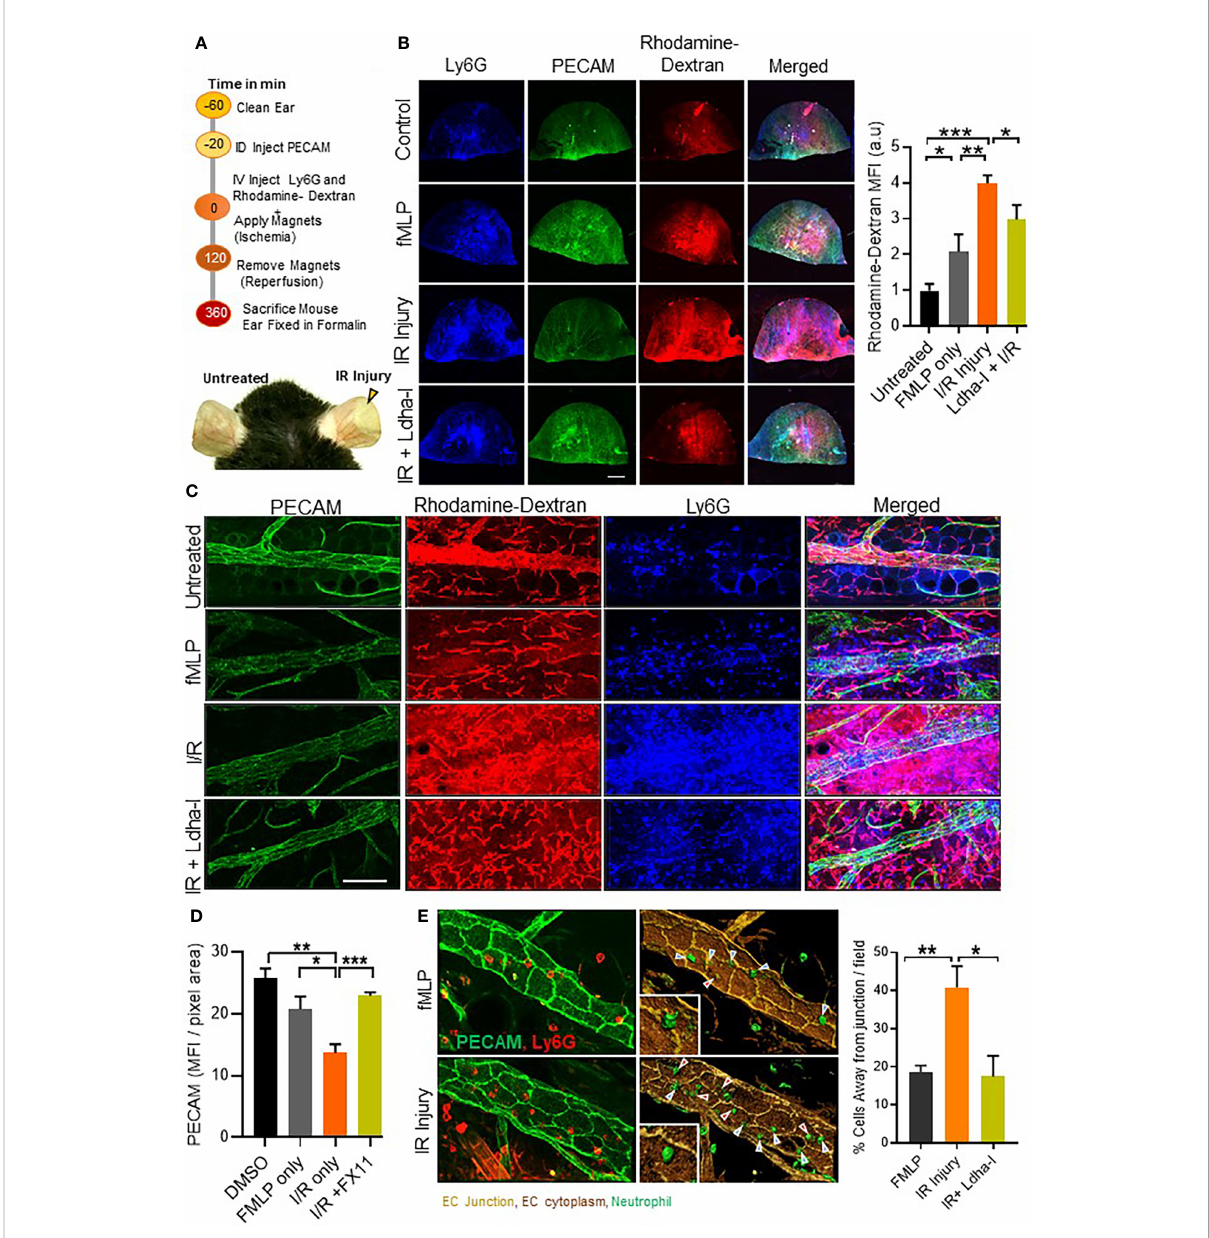
FIGURE 6 Neutrophil migration and vascular leakage in I/R injury. (A) Schematic illustration showing methodology adopted to induce I/R injury using gold- plated, N42-grade neodymium magnets in WT mouse ear vasculature. Representative image (bottom) of mouse ear, showing zone of I/R injury in the right ear, immediately after 2 h of ischemia and left ear without any treatment. (B) , Representative fl uorescent images of formalin fi xed whole ear vasculature showing Pecam-1 stained ear vasculature, Ly6G positive cells and rhodamine-dextran release in presence or absence of treatment as indicated. Bar graph represents fl uorescent quanti fi cation of rhodamine-dextran release into the ear, normalized to untreated group. (n=4 mice/condition, 4 independent experiments). (C) , Merged 2 fi elds under 60x objective showing in fi ltration of Ly6G positive cells (blue), rhodamine-dextran release (red) and Pecam-1 (green) staining in ear vasculature after indicated treatment. (D) , Bar graph (left) showing quanti fi cation of Pecam-1 fl uorescence in ear vessels using confocal z-stack images. (n=8 fi elds under 60x objective were analyzed, 1 of 2 independent experiments). (E) Representative 3D reconstituted images showing in vivo neutrophil transmigration, built over immuno fl uorescent images of ear vessel stained with anti-Pecam-1 (pseudo colored to light brown), endothelial cells body (dark brown) and neutrophils (green) using surface module of Imaris software. Cells away from junction (red arrows) and cells at the junction (blue arrows). Bar graph shows percentage of neutrophils migrating away from junction. (n=minimum 6 areas under 60x objective were analyzed, 1 of 2 independent experiment. Red arrow points to transcellular migration events. Mean ± SEM; *P < 0.05; **P < 0.001; ***P < 0.0004; using unpaired Student ’ s t test. Scale bar; (B) =2mm, (C) =50µm, (D) =